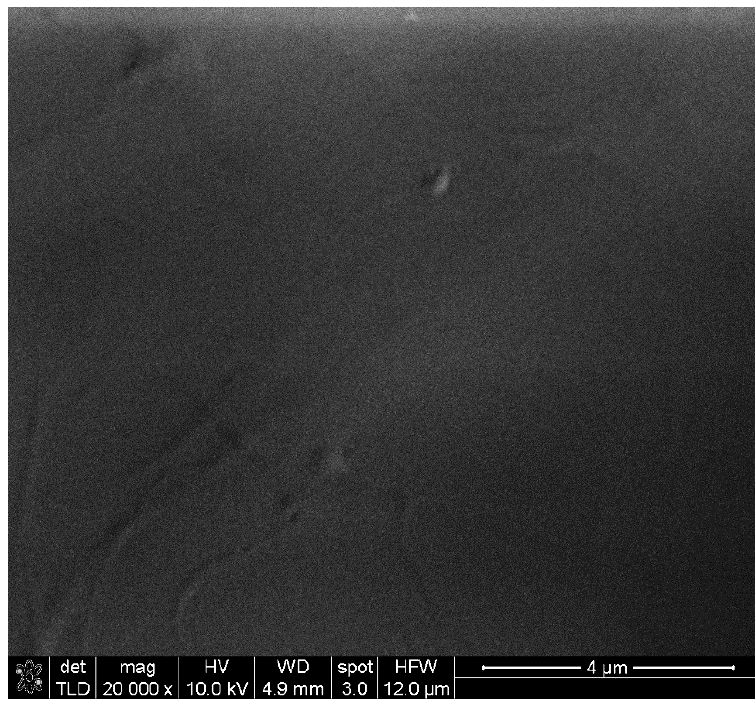
Figure 4. SEM characterization of pure PP surface (×20,000, Au coated).